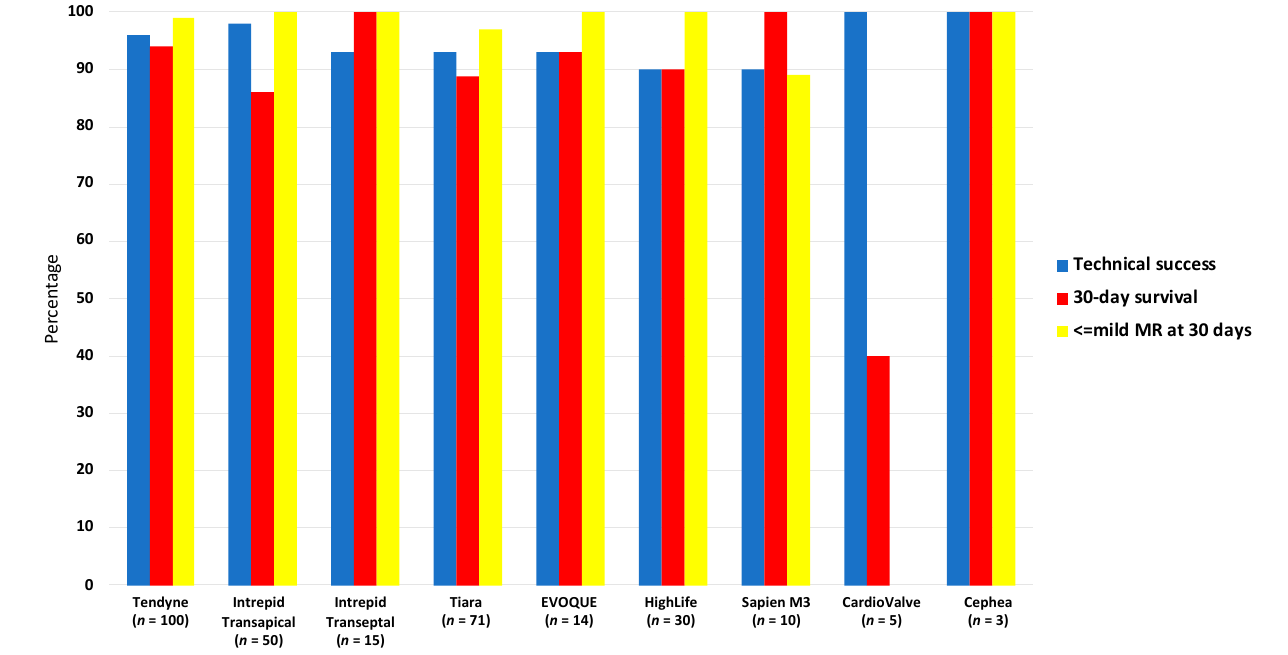
Figure 5. Procedural results following transcatheter mitral valve replacement.